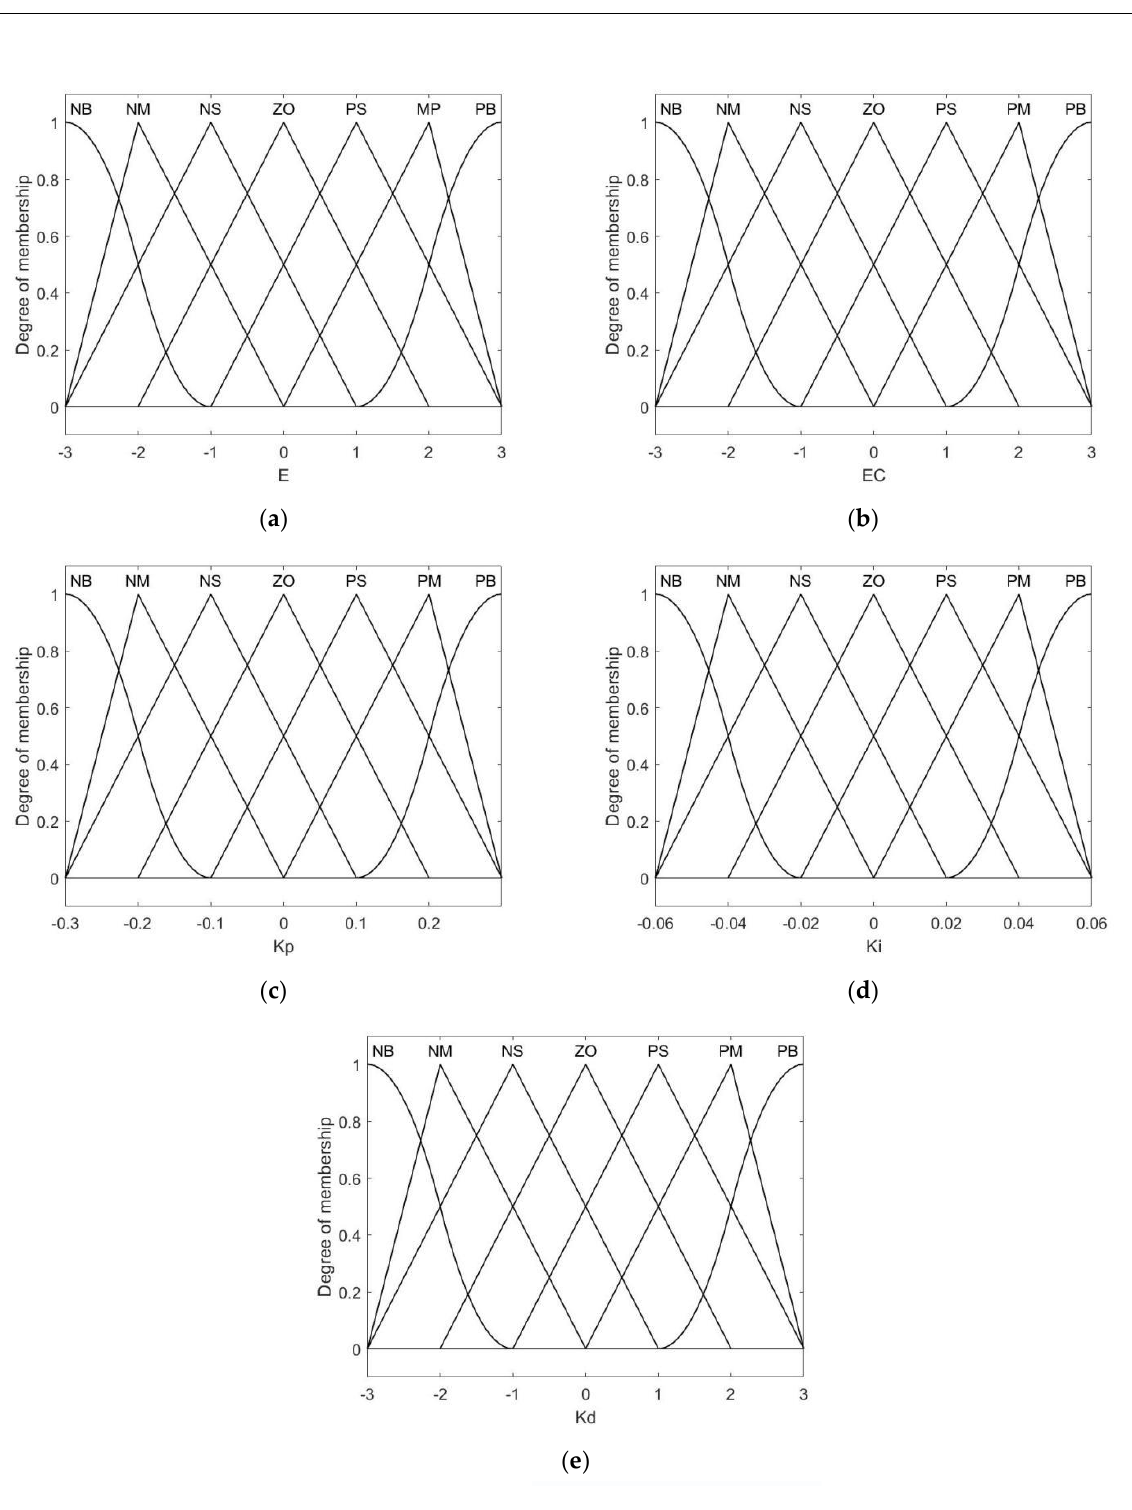
Figure 5. Membership function: ( a ) error; ( b ) changes in errors; ( c – e ) 𝐾 𝑝 , 𝐾 𝑖 , and 𝐾 𝑑 membership functions for fuzzy self-tuning PID, respectively.